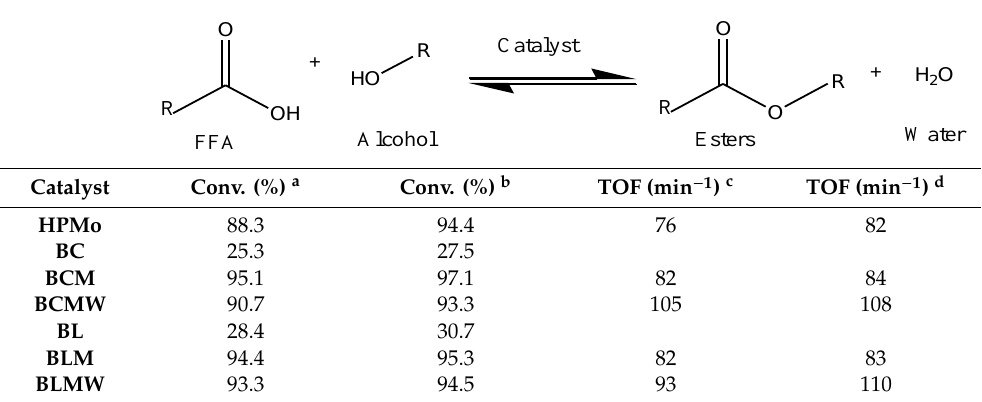
Table 3. Conversion and Turnover Frequency (TOF) data for raw materials and the fresh catalysts.